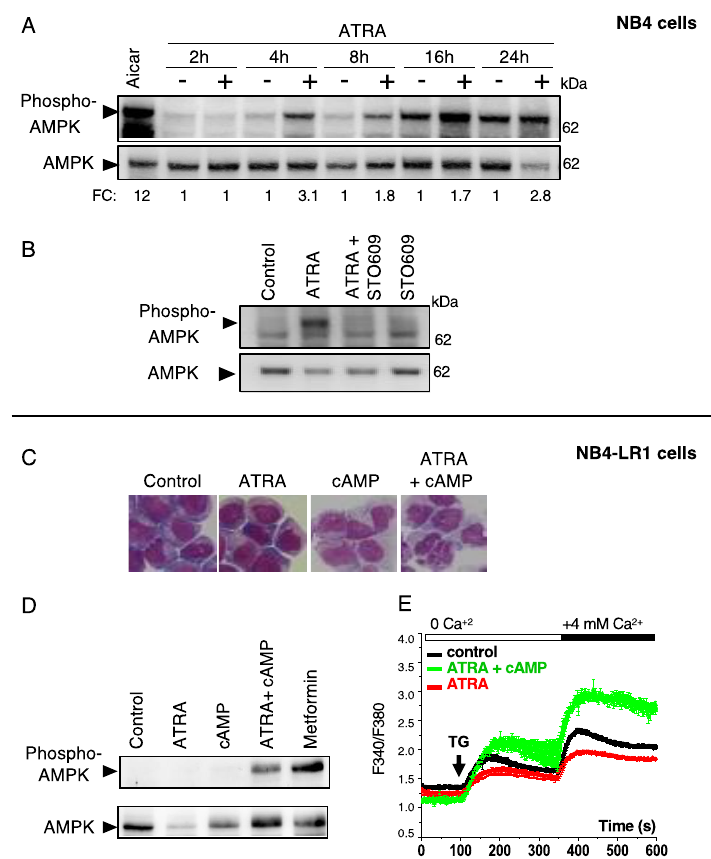
Figure 4. ATRA triggers AMPK activation in NB4 cells but not in NB4-LR1 cells. ( A ) Immunoblot analysis of phospho-AMPK and AMPK in NB4 cells treated with either an AMPK activator (AICAR, 500 μM, 2 h) or 1 μM ATRA for the indicated time. The expression levels of phospho-AMPK and AMPK were quantified and given as ratios of phospho-AMPK/AMPK relative to untreated cells. ( B ) Immunoblot analysis of the expression levels of phospho-AMPK and AMPK in NB4 cells pre-treated with or without STO609 (5 μg/mL) and then treated with 1 μM ATRA for 16h. ( C–E ) Maturation-resistant NB4-LR1 cells were treated with 1 μM ATRA and 100 μM 8-CPT-cAMP alone or in combination for indicated times. ( C ) Granulocytic differentiation was determined by morphological changes of cells stained with May–Grünwald– Giemsa after 3 days of treatments. ( D ) Immunoblot analysis of phospho-AMPK and AMPK proteins are shown. Metformin (2 mM, 2 h) was used as an AMPK activator. ( E ) Ca 2+ release and entry amplitudes were scored after 7 days of treatment as described in Figure 1.